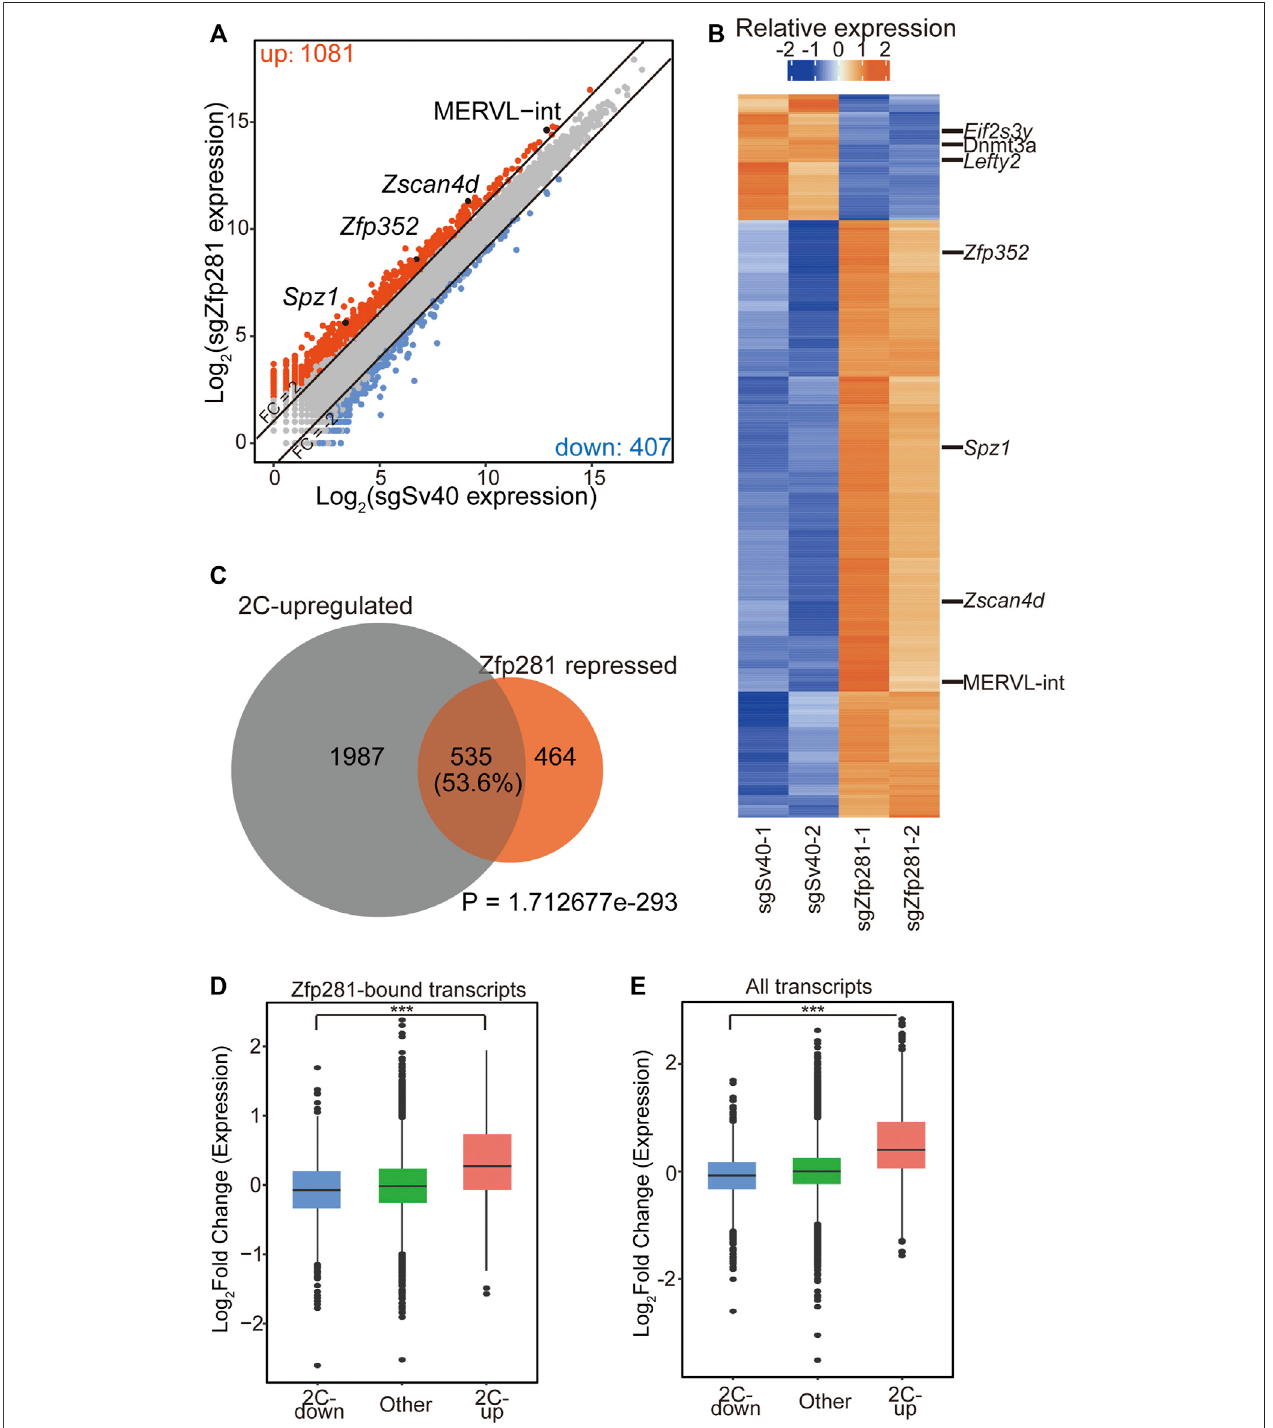
FIGURE 2 | Zfp281 impedes the expression of 2C-upregulated transcripts during the 2C-like transition. (A) A scatter plot comparing the gene/repeat expression pro fi lesbetweencontrolandZfp281-perturbedmESCsafter Dux induction.ThecriteriaforgenechangesareFoldchange(FC) > 2andFalsediscoveryrate(FDR) < 0.05. (B) A heatmap showing the relative expression levels ofdifferential expression genes/repeats (FC > 1, FDR < 0.05) from two biologically independent samples of control and Zfp281-perturbed mESCs after Dux induction. (C) A Venn diagram demonstrating overlaps of Zfp281-repressed transcripts and 2C-upregulated transcripts. Zfp281-repressed transcripts are de fi ned as the transcripts activated in Zfp281-perturbed mESCs compared to control mESCs after Dux induction (FC > 2 and FDR < 0.05). p Value was calculated by a hypergeometric test. (D) A box plot showing the log 2 (FC) of Zfp281-bound transcripts after Dux induction. Within all